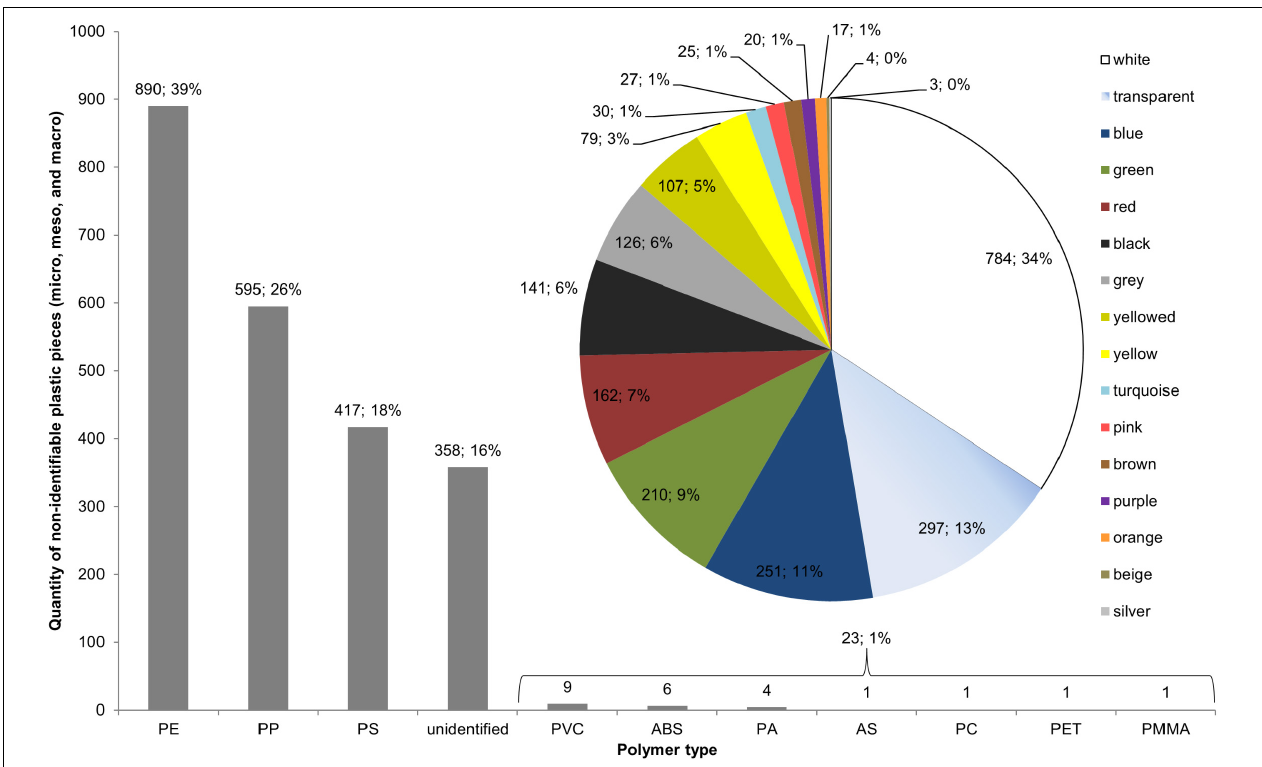
FIGURE 4 | The quantity per polymer type (gray bars) and the color (pie chart) of 2283 non-identifiable plastic pieces (micro, meso, and macro) from the 205 surveys of the beaches around the Baltic Sea (including St. Petersburg).